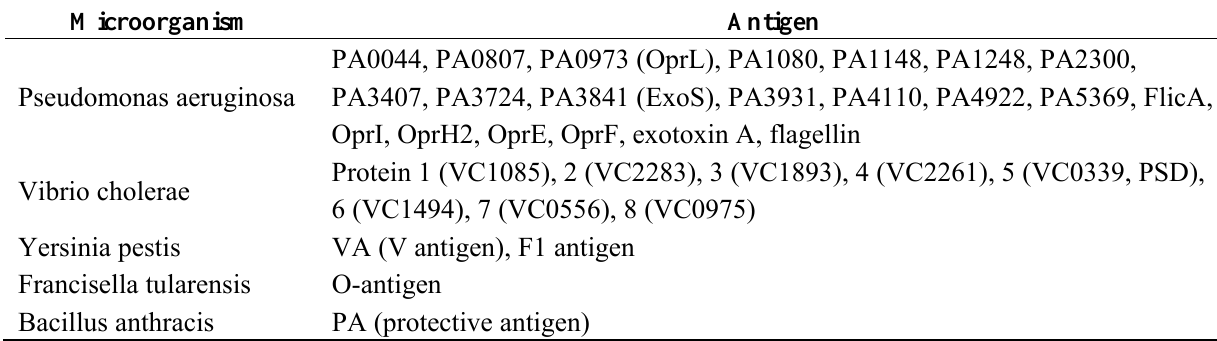
Table 4. Genes which interact with immunological human